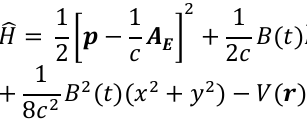
Fig. 1. (a) HHG spectra resulting from a circularly polarized driver laser without magnetic field (blue line) and with the magnetic field linearly-polarized. (b) Attosecond pulse arising from the spectra with the magnetic field in panel a), filtering above the 70 th harmonic order (blue line). The measured FWHM pulse duration is approximately 29 as. The Fourier-limited pulse, plotted in green, shows a FWHM around 27